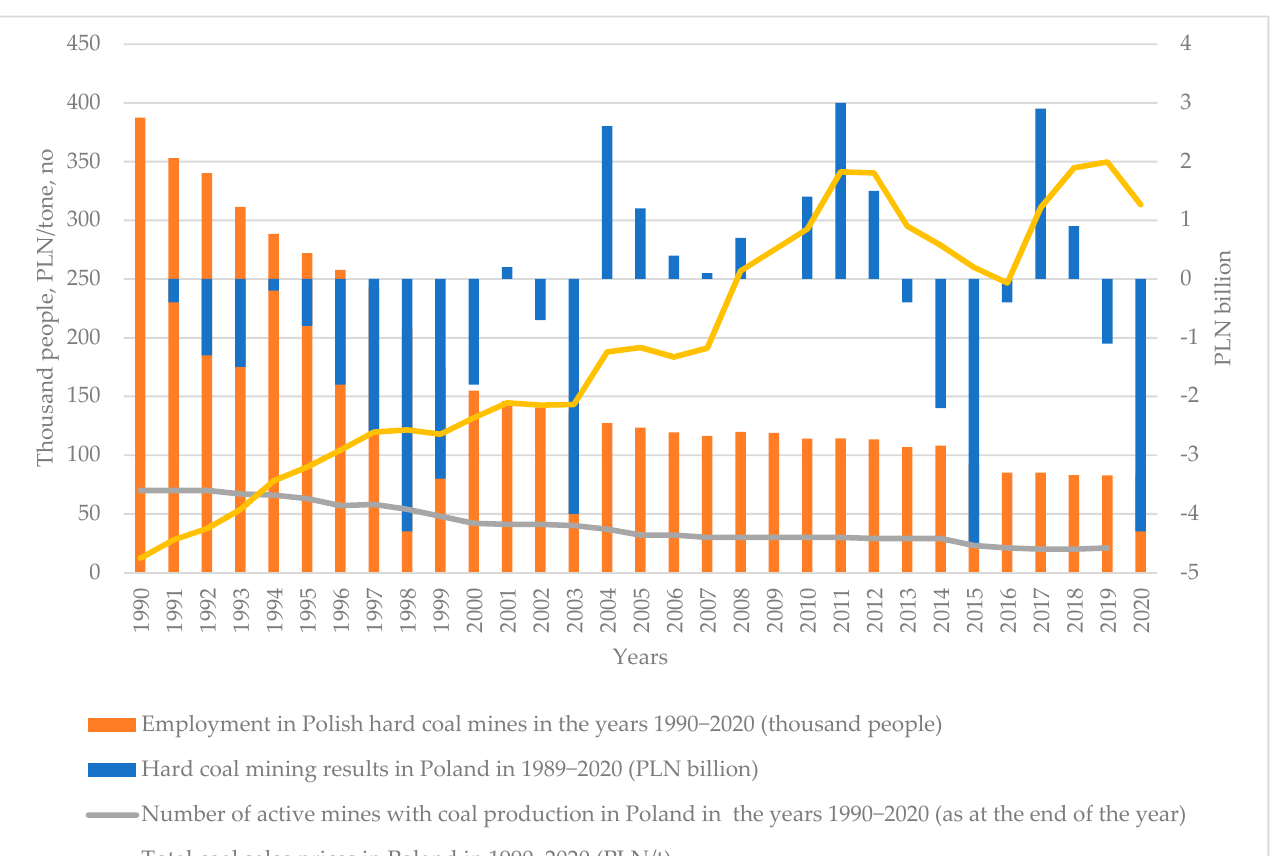
Figure 1. Employment, hard coal mining, number of active mines and total coal sales in Polish coal sector. Source: own analysis based on Statistic Poland.